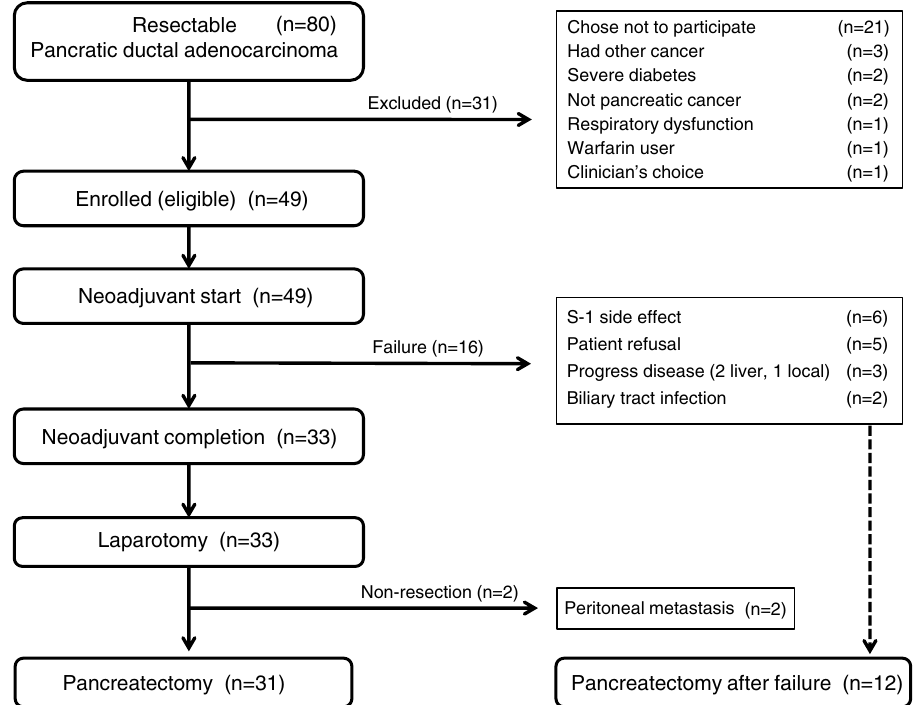
Figure 1. CONSORT diagram of the study flow. A total of 80 patients gave informed consent for the HOPS-R01 trial between January 2014 and October 2015 and were diagnosed with resectable pancreatic ductal adenocarcinoma by a central review of multidetector computed tomography. Neoadjuvant (Nac) S-1 at 80 mg/ m 2 per day was administered for 28 consecutive days followed by a 14-day rest (one cycle). The administration of S-1 was repeated every 6 weeks for two cycles. Of 49 patients who started Nac, 33 patients completed Nac and 31 patients received pancreatectomy. Of 16 Nac-failure patients, 12 patients underwent resection (pancreatectomy).